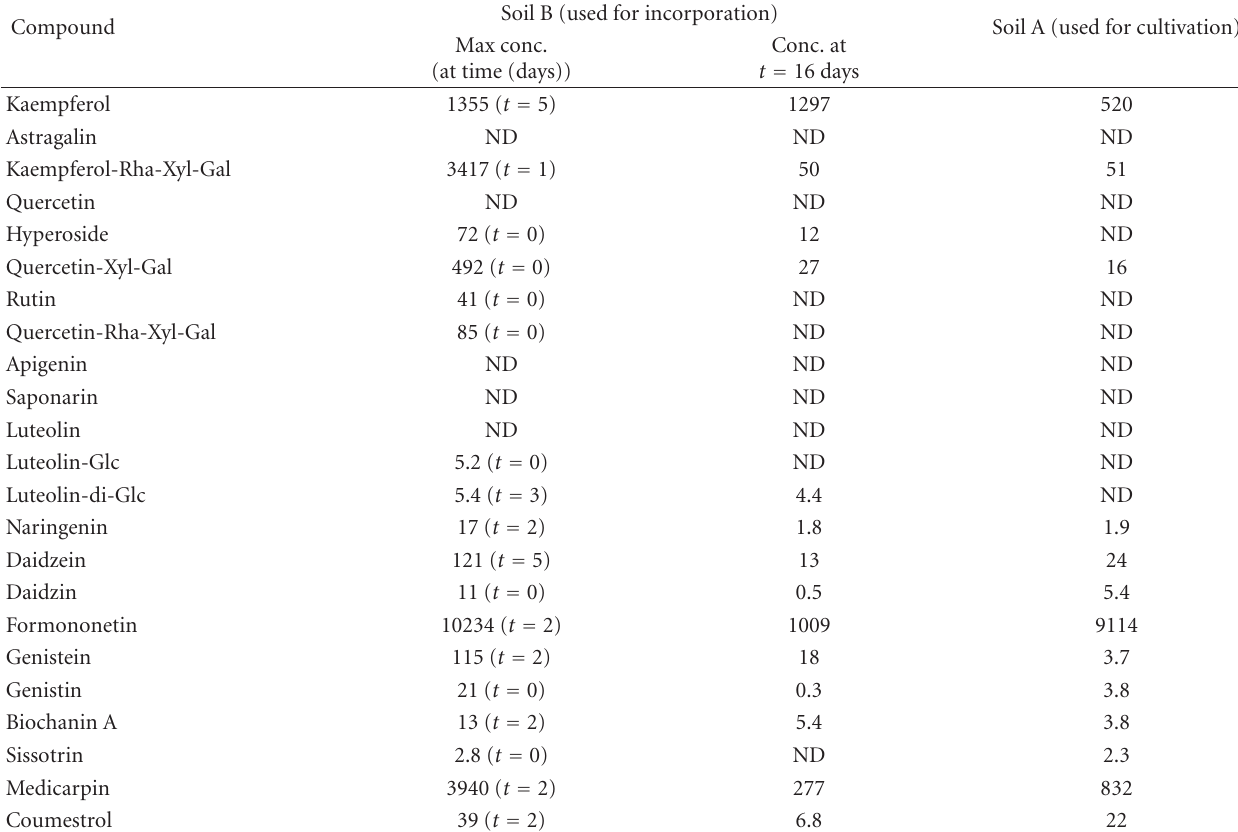
Table 6: The maximum available concentration in soil B after incorporation of white clover plant material and at t = 16 days after incorporation, and the concentration of available flavonoids in soil A (nmol/kg dry weight). Values represent the mean of two replicate analyses. Soil B (used for incorporation) Compound Soil A (used for cultivation) Max conc. Conc. at t = 16